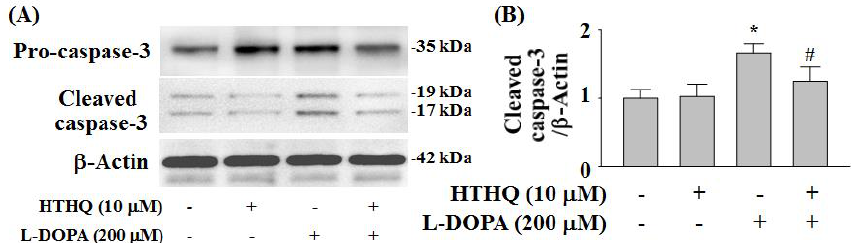
Figure 6. Effects of HTHQ on L -DOPA-induced cleaved caspase-3 expression in PC12 cells. PC12 cells were exposed to L -DOPA (200 µ M) (+) in the absence ( − ) or presence (+) of 10 µ M HTHQ for 24 h. The cleaved caspase-3 was analyzed with Western blotting ( A ) and the values of the relative density ratios of cleaved caspase-3/ β -actin are expressed in arbitrary units ( B ). The results are expressed as the means ± S.E.M. (n = 4). * p < 0.05 compared to L -DOPA-untreated group, # p < 0.05 compared to L -DOPA-treated group (200 µ M) (ANOVA with post-hoc Tukey’s test).